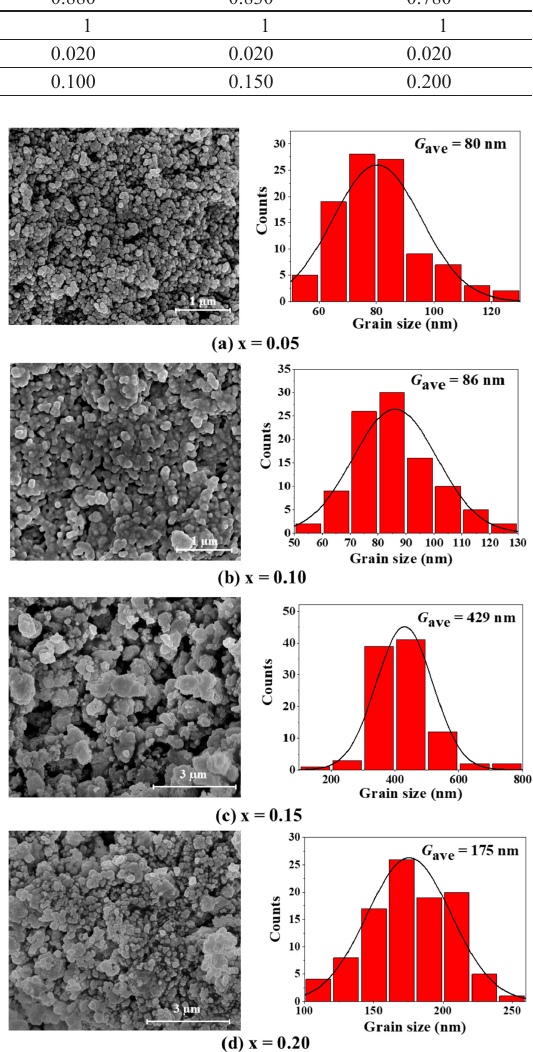
Figure 3. Fractured surface morphologies and the corresponding grain size distributions for the K (b) x = 0.10, (c) x = 0.15 and (d) x =